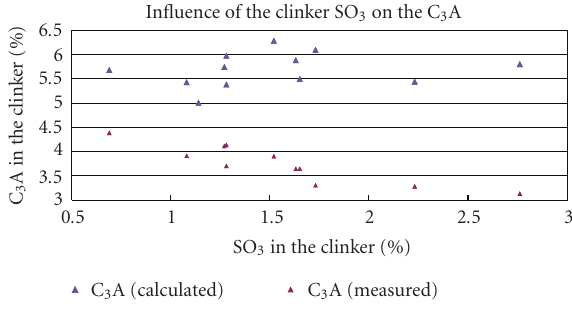
Figure 1: Influence of the clinker SO 3 on the C 3 A.